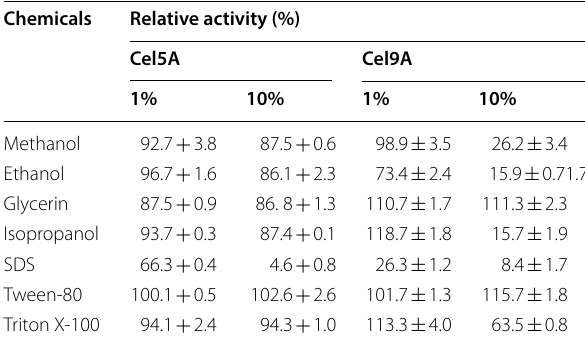
Table 2 Effect of chemical reagents on recombinant